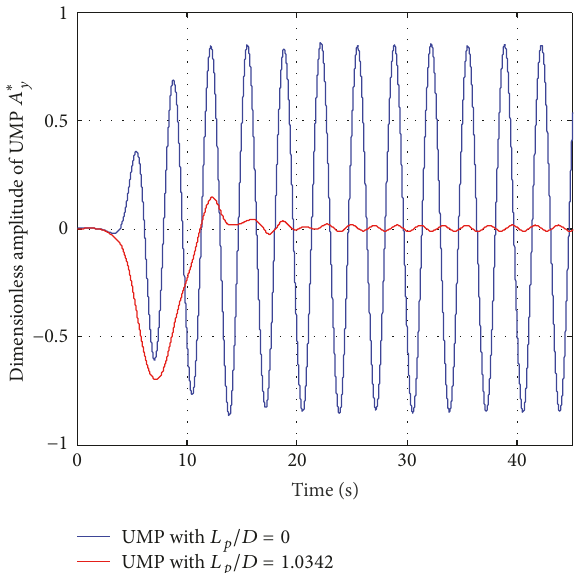
Figure 22: Dimensionless amplitude of the bare UMP and UMP with plate based on optimal parameter.